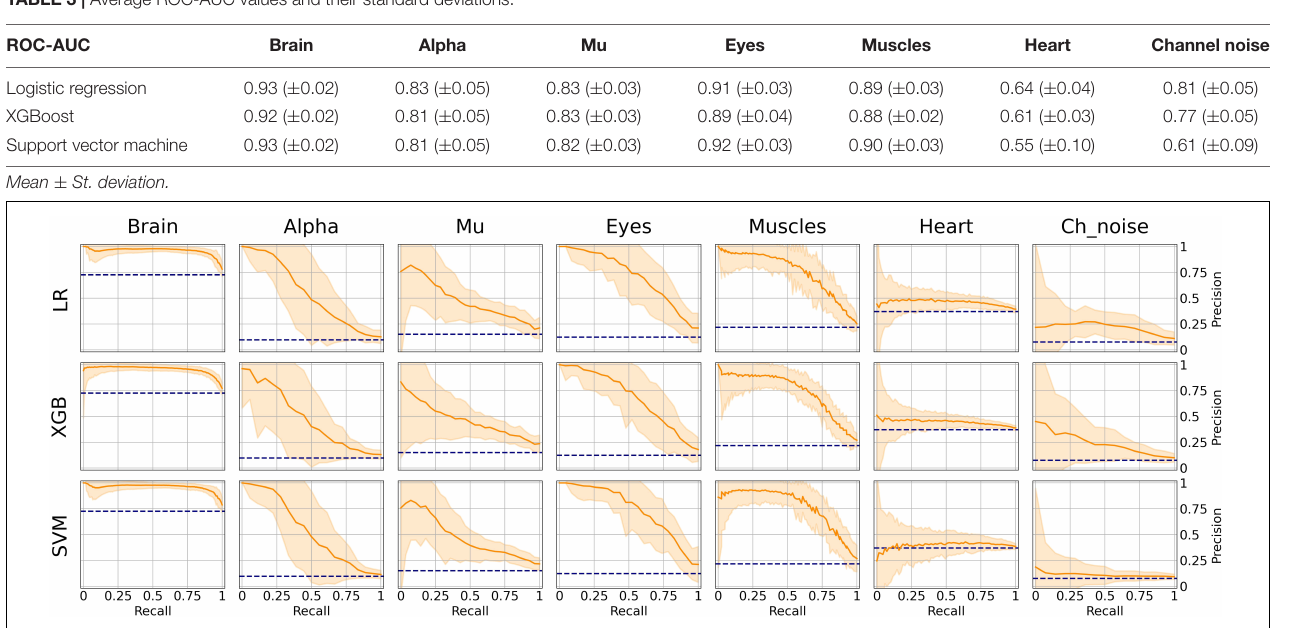
FIGURE 7 | Aggregated Precision Recall (PR) curves for all IC types and ML models. The solid line indicates the mean curve and the colored area indicates the 95% confidence interval for the PR curve. PR curves better indicate classification performance in case of imbalanced data, which can be seen in worse results for Alpha, Mu, Eyes, and especially Channel Noise IC types, all of which have fewer positive labels compared to Brain or Muscles IC classes. As with the ROC curves, we can claim that on all IC types except for Heart and Channel Noise, our models perform significantly better than the unskilled classifier. TABLE 4 | Average PR-AUC values and their standard deviations. PR-AUC Muscles Heart Channel noise Logistic regression Support vector machine